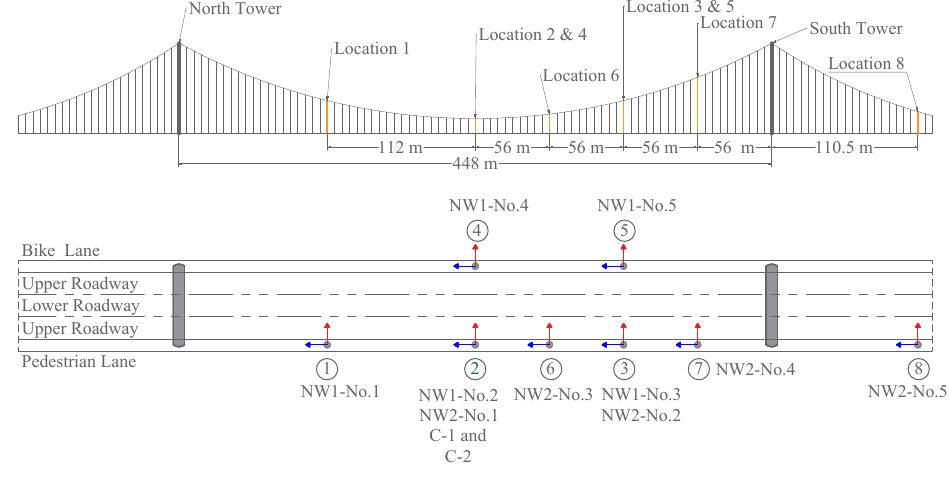
Figure 8. Sensors’ location along the bridge.